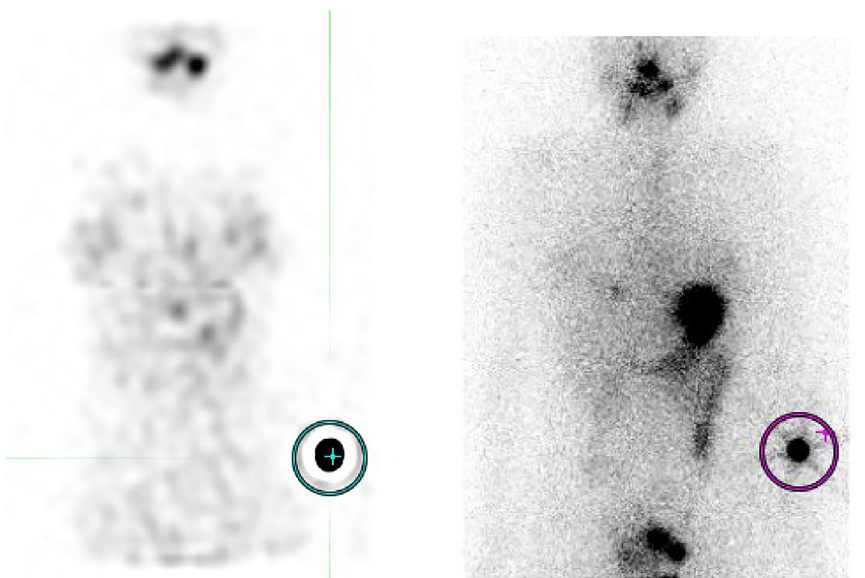
Figure 2. One example of the determination of region of interest (ROI). The diameter of the ROI was 5 cm and the center of the ROI was set at the center of the accumulation. Right: planar image, Left: single-photon emission computed tomography